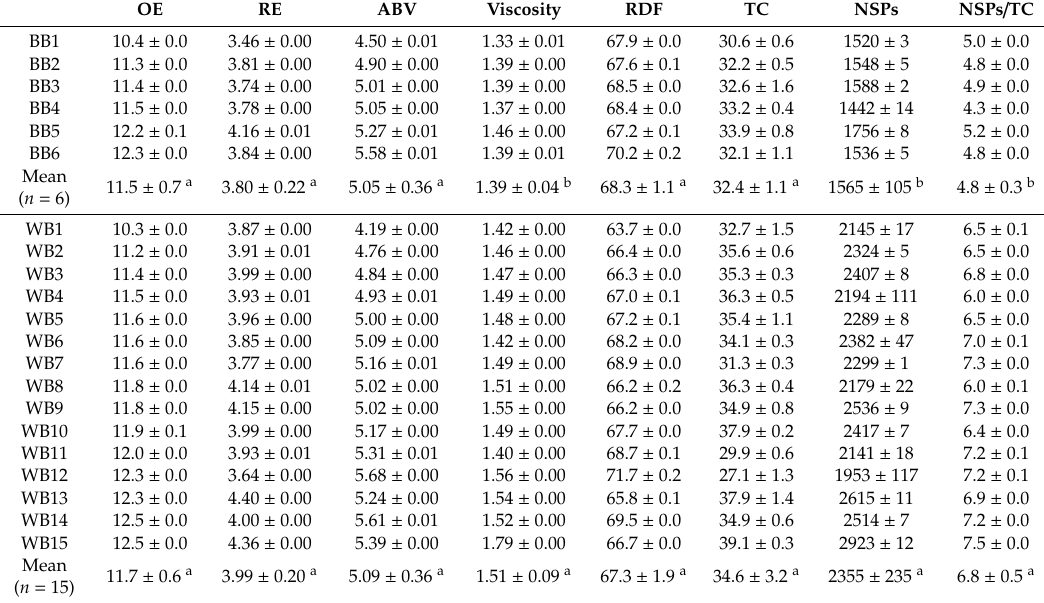
Table 2. Overview of beer main physicochemical indices, total carbohydrate, and total non-starch